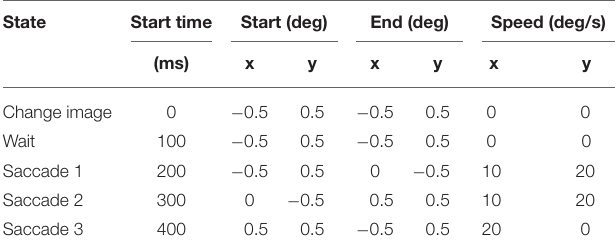
GUI enters the Change Image state and the rest of the process is automated.